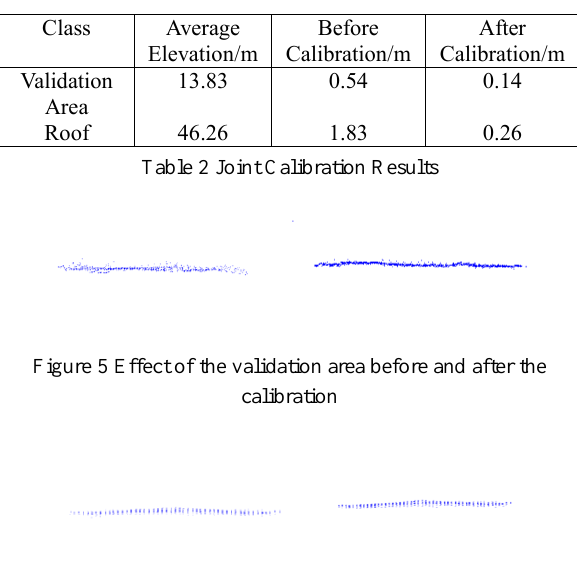
Figure 6 Effect of the roof before and after the